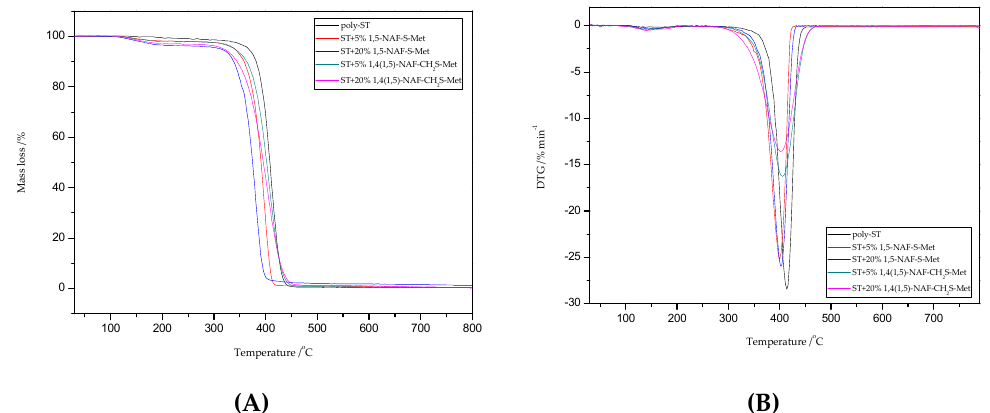
Figure 9. The TG ( A ) and DTG ( B ) curves of poly-MMA and its copolymers with 5% and 20% content of 1,5-NAF-S-Met and 1,4(1,5)-NAF-CH 2 S-Met.